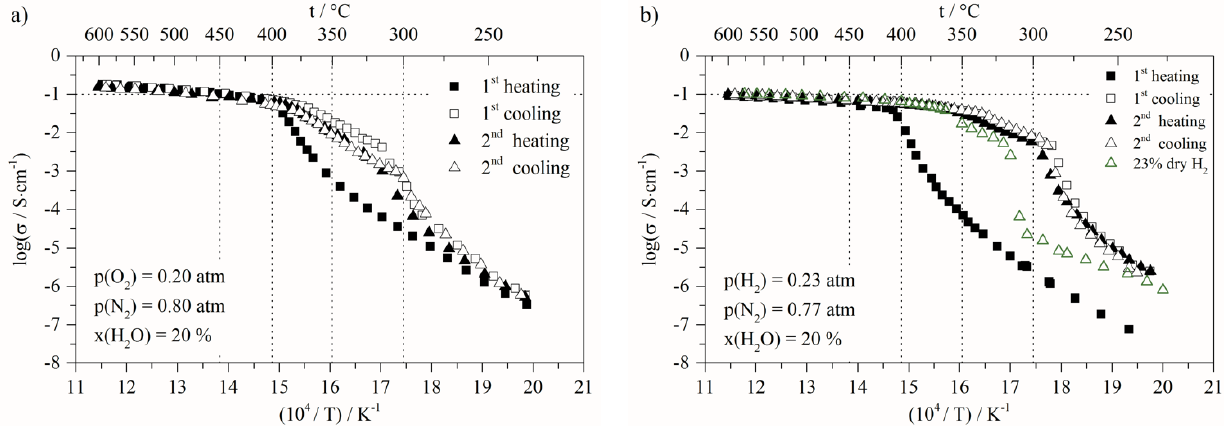
Figure 6. Influence of H 2 O addition on electric behavior and stability of SDC—LiNaK composite electrolyte in: ( a ) oxidizing atmosphere (moistened synthetic air) and ( b ) reducing atmosphere (moistened 23%—H 2 —in—N 2 mix). Arrhenius diagrams represent two heating/cooling cycles for both atmospheres. Symbols indicating the dry hydrogenated atmosphere (dry 23%—H 2 —in—N 2 ) correspond to first cooling step on Figure 4b.